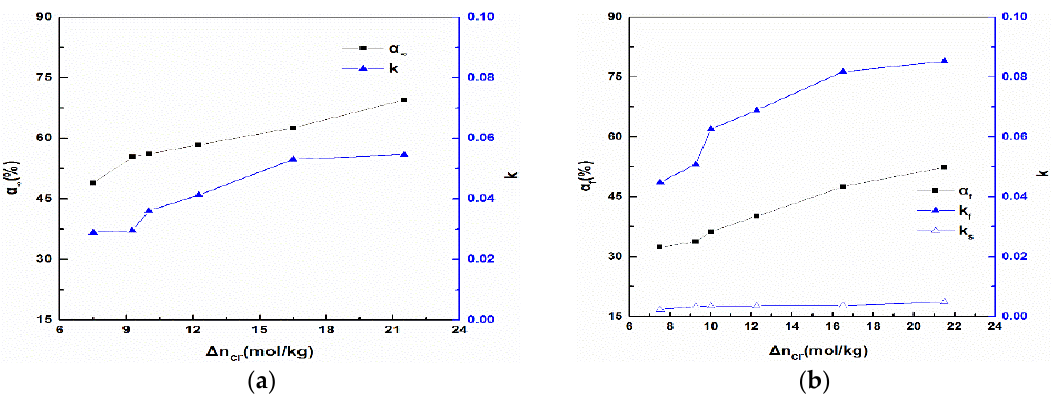
Figure 3. Dynamics fitted results of hydration process data: ( a ) first-order model; ( b ) multi-rate model.